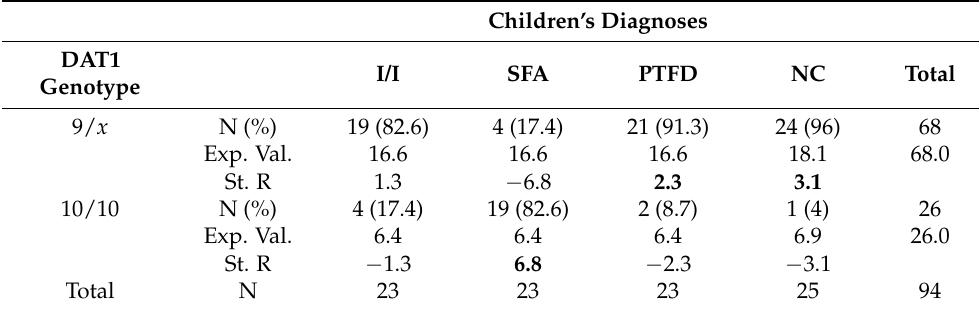
Association between children’s dopamine transporter (DAT1) genotype and children’s